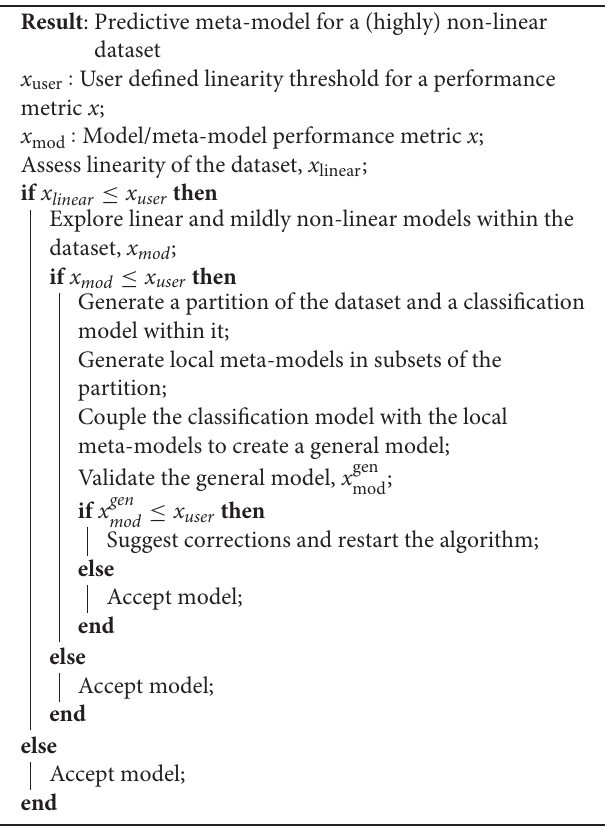
Algorithm 1: RV-Clustering